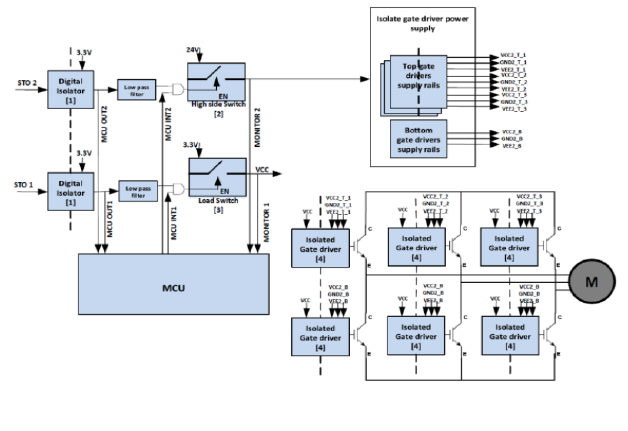
Figure 2. Block Diagram of STO function